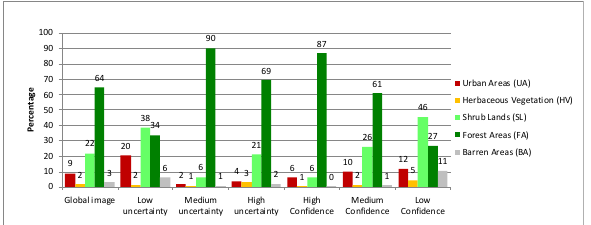
Figure 8. Percentage of area assigned to each class in the global image and in the regions with low, medium and high uncertainty and confidence